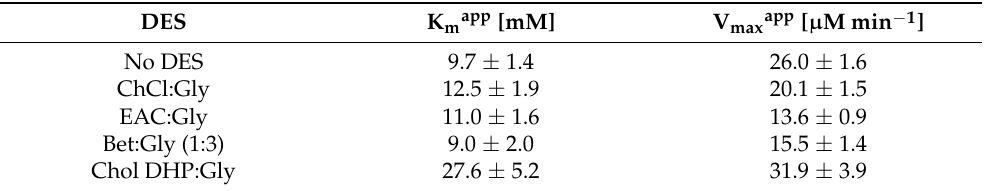
Table 2. Apparent kinetic parameters of tyrosinase mCLEAs for the oxidation of L-DOPA in 10% v / v aqueous solutions of DESs with the same HBD.